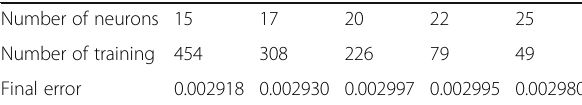
Table 3 BP neural network training